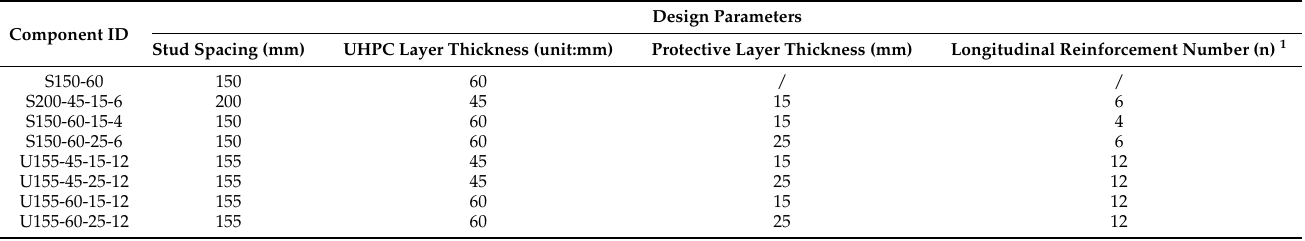
Table 1. Design parameters of steel–UHPC composite slab and composite beam. Design Component ID